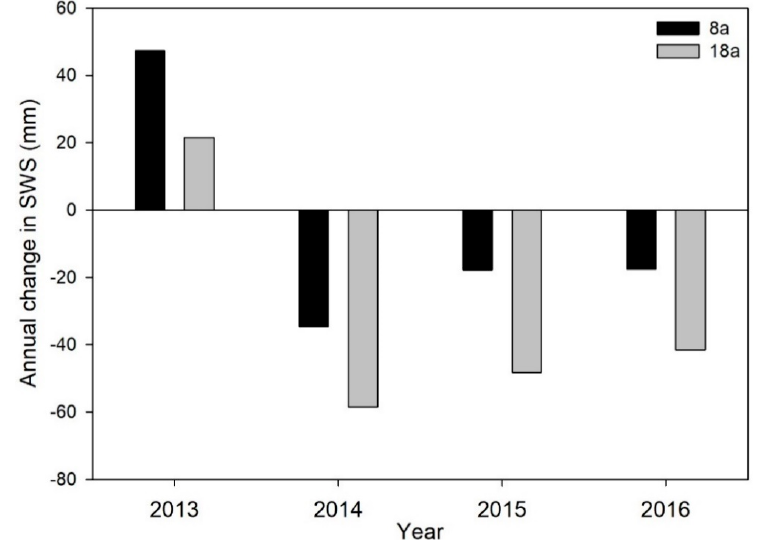
Figure 7. Annual change in soil-water storage (SWS) for the 8- and 18-year-old apple orchards (8a and 18a, respectively) in 2013, 2014, 2015, and 2016.